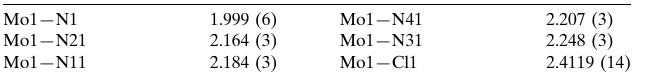
Selected bond lengths (A˚ ).